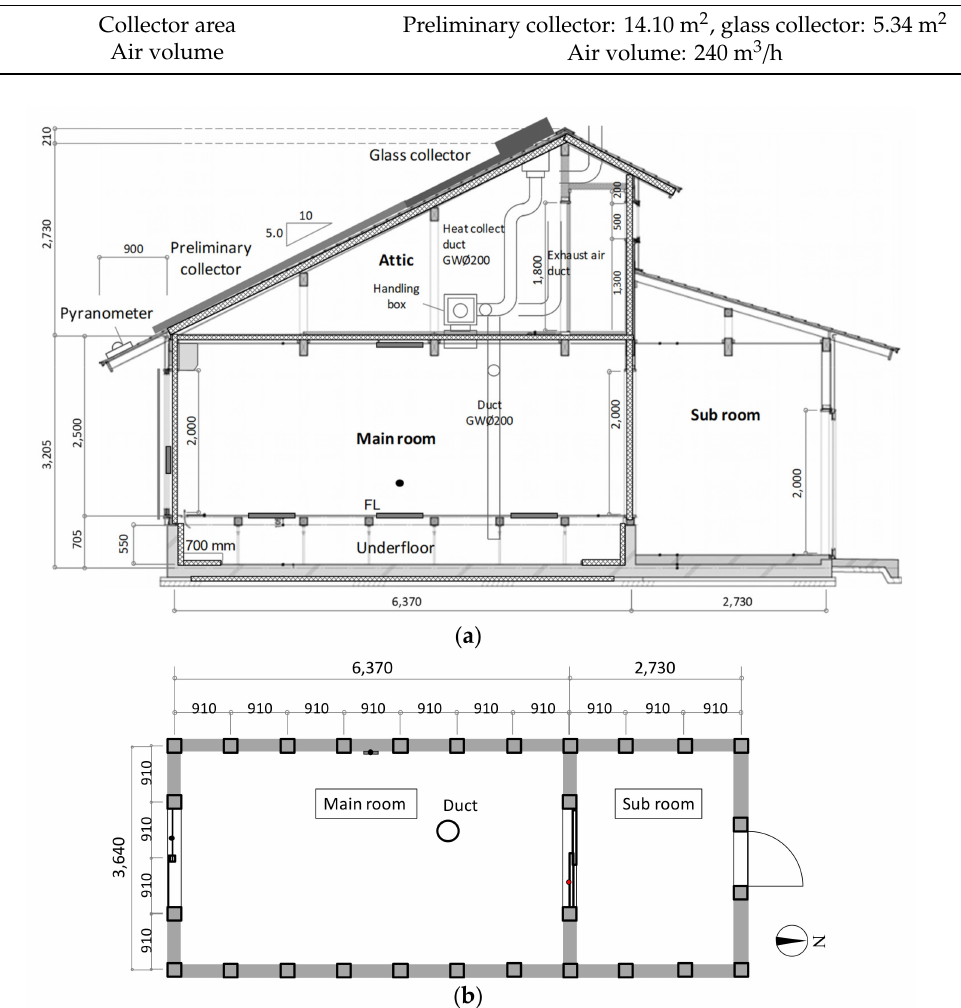
Figure 1. Target building. ( a ) elevation; ( b )